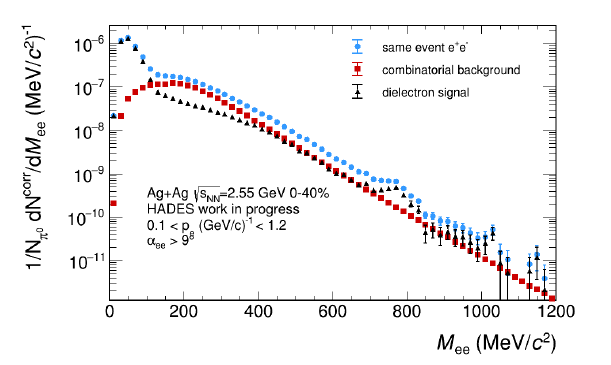
Figure 3. E ffi ciency corrected invariant mass distribution of reconstructed dielectrons in the HADES acceptance. Subtracting the combinatorial background (see text for the calculation details) from the same-event data yields the signal